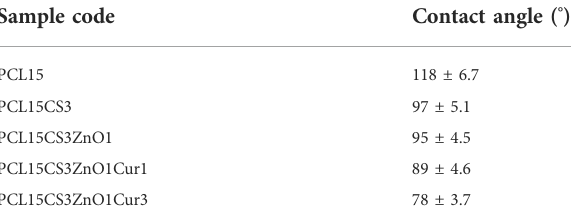
TABLE 4 WCA values of the electrospun nano fi bers. Sample code